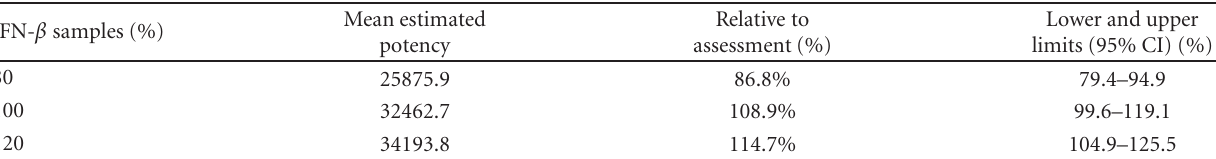
Table 3: Relative potency of IFN- β as determined by RGA.